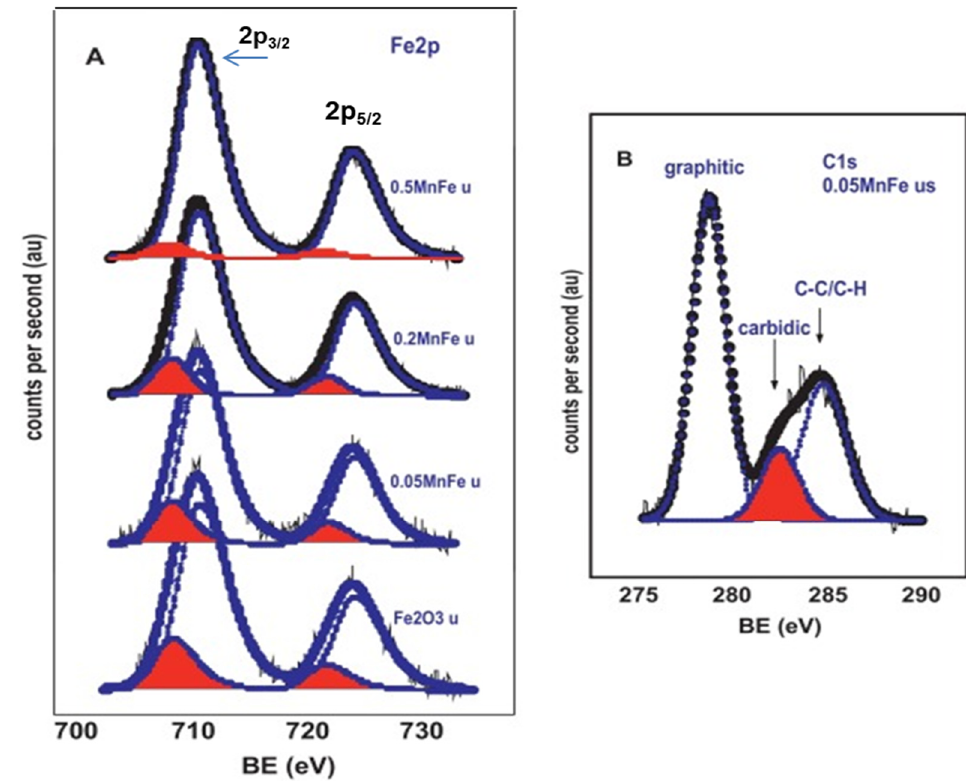
Figure 9. ( A ) Fe 2p core-level spectra of spent MnFe catalysts tested in the CO 2 hydrogenation. The red color refers to iron carbide species. ( B ) C 1s spectrum of the most active 0.05MnFe catalyst showing different carbon species. Reproduced from Ref. [19] with copyright license from Elsevier (2021).